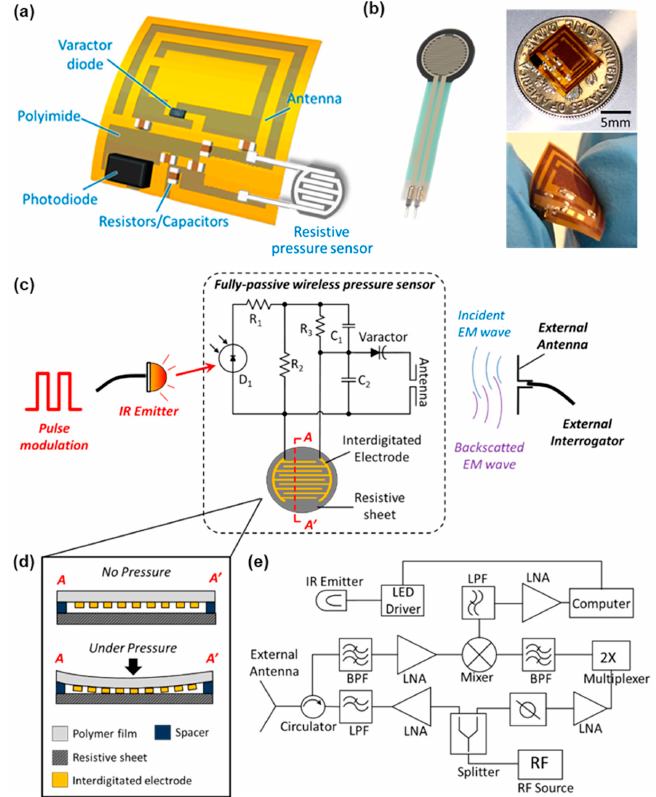
Figure 5. Wireless intracranial pressure (ICP) monitoring through a fully-passive method. ( a ) Illustration of the fabricated wireless fully-passive pressure sensor. ( b ) Photograph of the thin film force sensing register (FSR 402, Interlink Electronics, Camarillo, CA, USA) used for the resistive pressure sensor (Left) and the wireless fully-passive pressure sensor fabricated on a flexible polyimide substrate (Right). ( c ) Overall view of the system operating principle. Wireless fully-passive pressure sensing is accomplished using both infrared (IR) and radiofrequency (RF) electromagnetic energy. The photodiode (D 1 ) on the sensor receives the modulated IR light from the external LED IR emitter and generates an electrical voltage signal, which has the same waveform as the external modulation pulse. The generated pulse is voltage divided by the resistors R 1 -R 3 and the pressure-sensitive resistor ( d ), and outputs to the varactor diode. The voltage across the varactor diode is mixed with incident RF energy and wirelessly transmitted to the external interrogator using the RF backscattering method. The external interrogator then extracts the pressure information through a series of demodulation and calculation processes. ( d ) Operation principle of the pressure-sensitive resistor. The resistor comprises a pair of interdigitated electrodes which are printed on a flexible polymer film. The polymer film is placed on top of a resistive sheet with a spacer sandwiched between. Under external pressure, the polymer film deforms and results in contact between the interdigitated electrodes and the resistive sheet, lowering the resistance of the resistor. ( e ) Detailed structure of the external interrogator for extracting the pressure value.